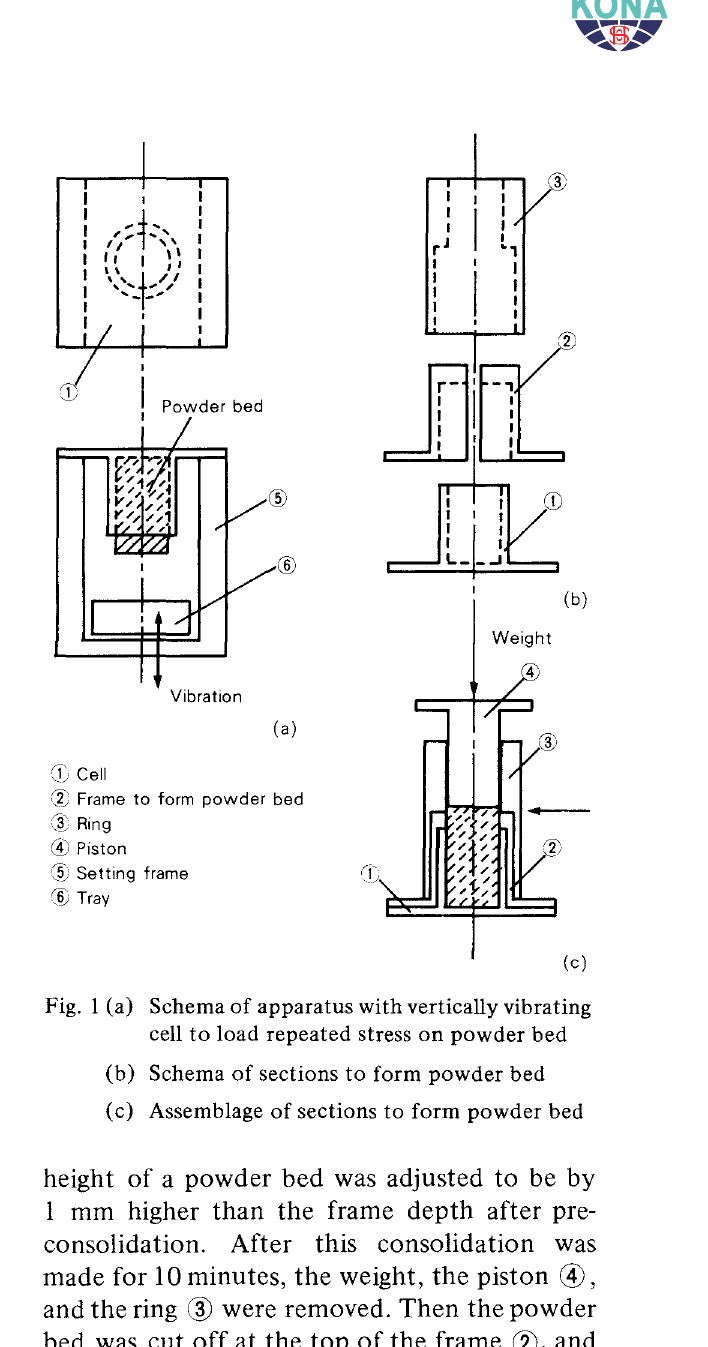
Fig. 1 (a) Schema of apparatus with vertically vibrating cell to load repeated stress on powder bed (b) Schema of sections to form powder bed (c) Assemblage of sections to form powder